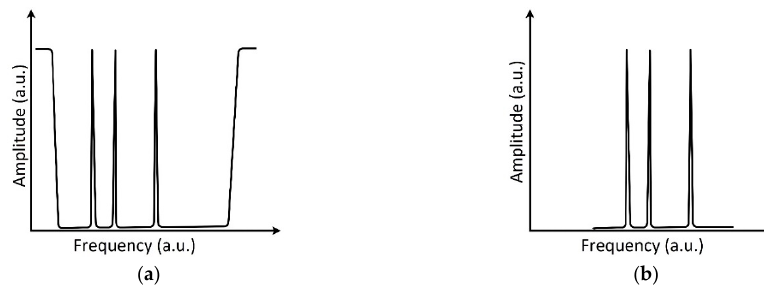
Figure 1. Amplitude–frequency diagrams: ( a ) transmitted through Multi-Addressed Fiber Bragg Structure (MAFBS), formed using Fiber Bragg Gratings (FBG) with π -shifts; ( b ) reflected from MAFBS, formed as a set of ultra-narrowband FBGs.